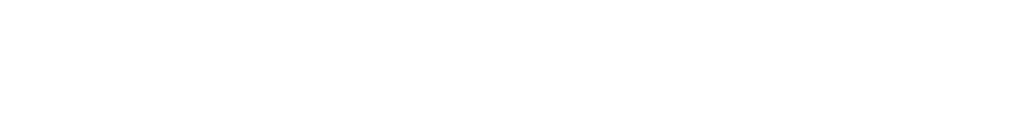
Logopediese Vereniging, Vol. 17, Nr. 1: Des.